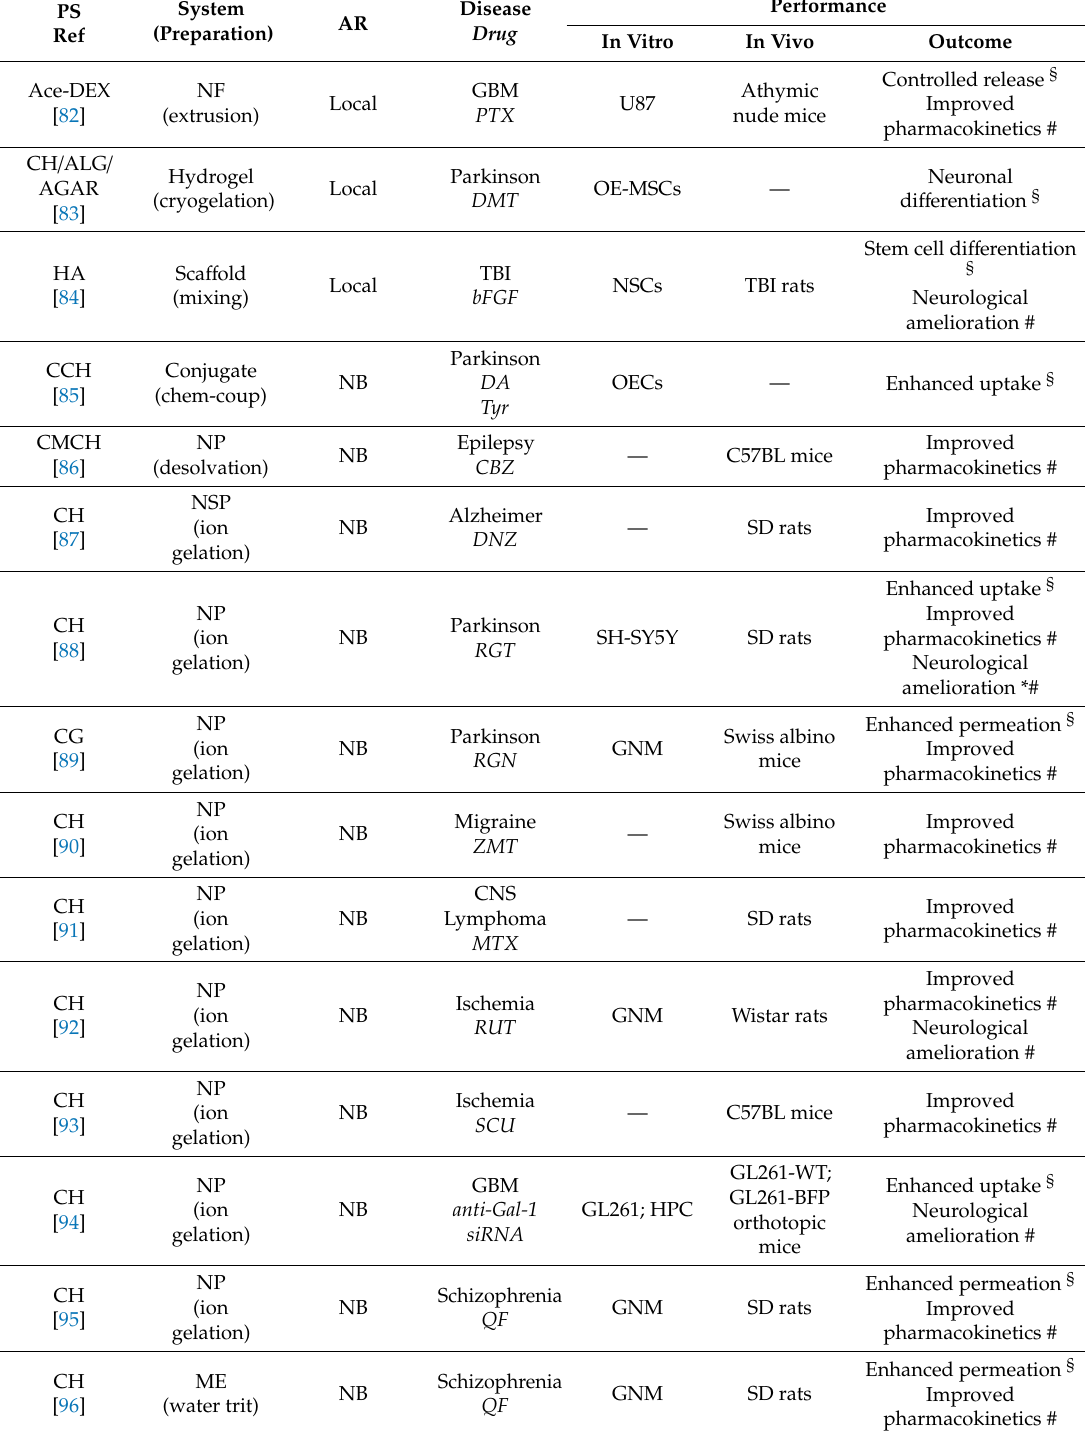
Table 3. Brain targeting strategies modifying the PSC administration